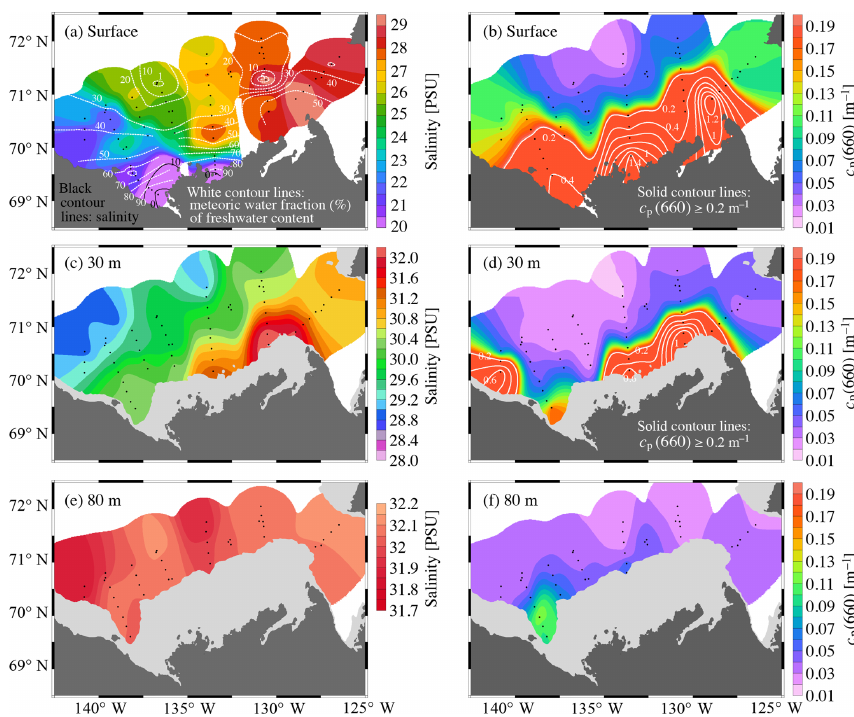
Figure 2. Fields of water salinity (a, c, e) and particulate beam attenuation coefficient at 660nm (cp(660), a , c , e ) for (a) – (b) sea surface, (c) – (d) 30m, and (e) – (f) 80m during the MALINA 2009 expedition. The presented results in (a) include both barge and only CTD rosette measurements from the CCGS Amundsen , but only CTD rosette measurements in (b) – (f) marked by black dots. Black contour lines in (a) mark salinity in the estuary, while the white dashed contour lines are the fraction of meteoric water (%) of the freshwater calculated using samples collected by both barge and CTD